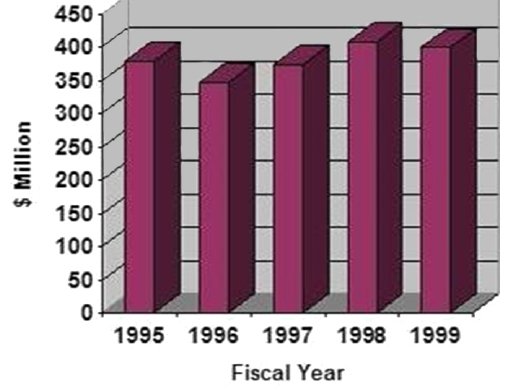
Fig. 2. Hurricane Impacts on USVI Employment Source: US Bu- reau of Labor Statistics, Haver Analytics (after Bram and Hastings, 2013).